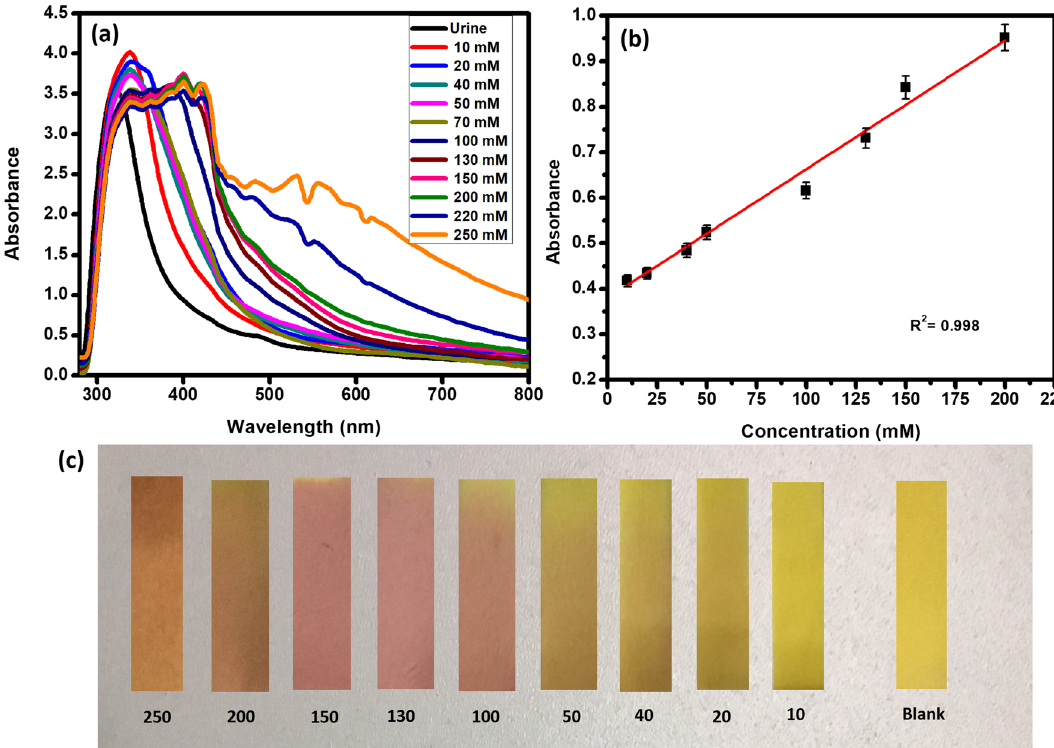
Figure 9. ( a ) Absorbance profile of biological urine samples upon the addition of CuC. ( b ) Linear responses of absorbance changes with respect to the concentration of Na + in the simulated urine samples. ( c ) Photograph of CuC-paper test strips with different concentrations of Na + containing urine samples. Error bars represent standard error of the mean (n = 5).